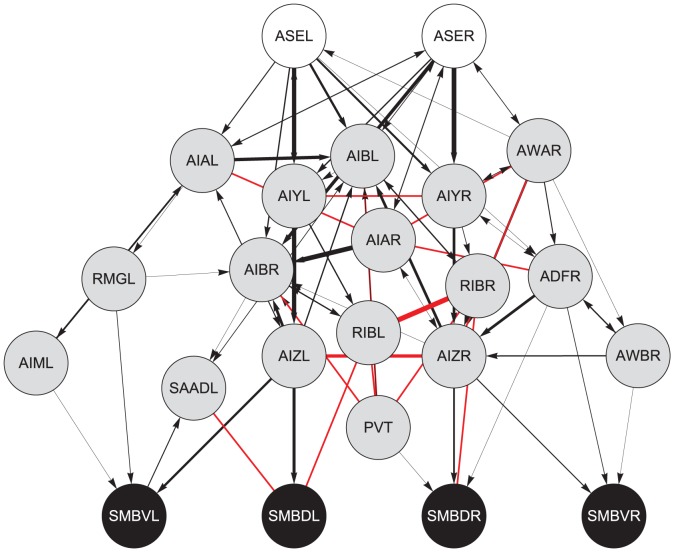
Neuroanatomical network connecting ASE to SMB, constrained to paths of length 3, but without a contact threshold.White disks, chemosensory neurons; gray disks, interneurons; dark gray disks, motor neurons. (Note: ADFR is a chemosensory neuron, but it is not shown in white because it is not in the original target set. Similarly, RMGL is a motor neuron, but it is not shown in black because it is not in the motor target set). Black connections represent chemical synapses; red connections represent electrical gap junctions.